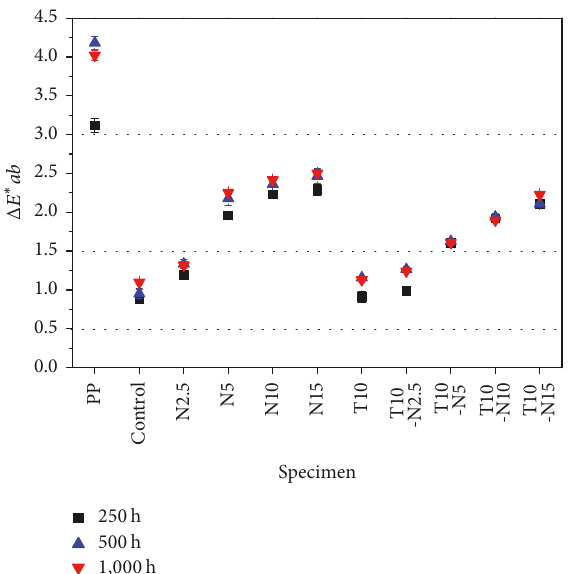
Figure 8: Color difference value of PP, control, NCC-only, and NCC-talchybridfilledPP-basedcompositesafteracceleratedweath- ering